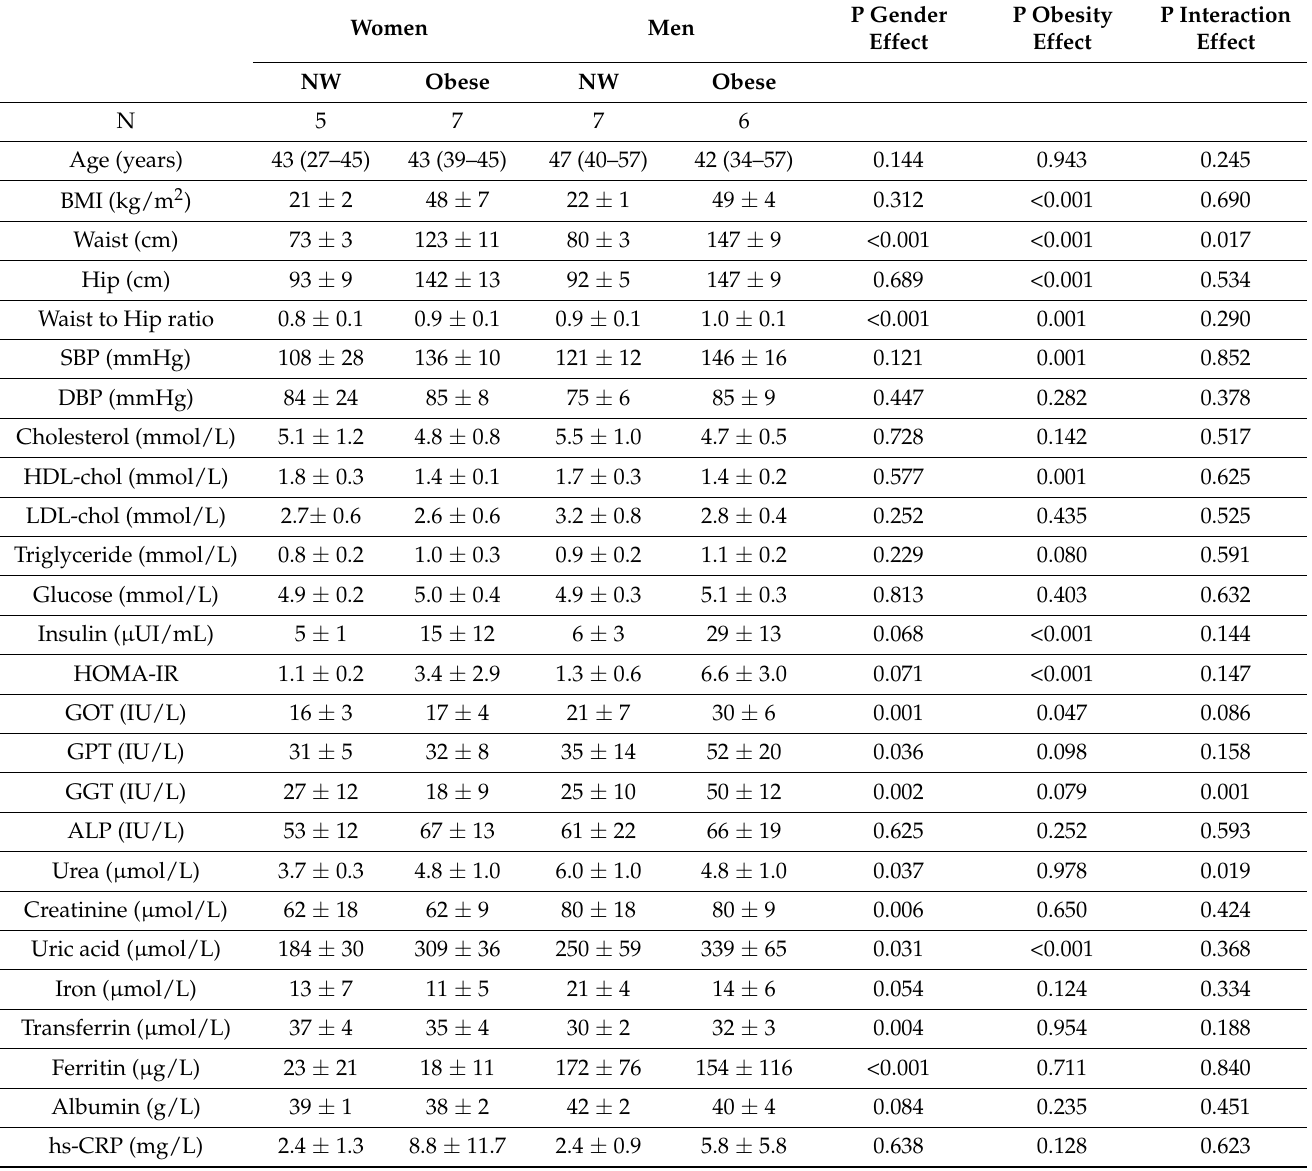
Table 1. Clinical and metabolic variables in women and men